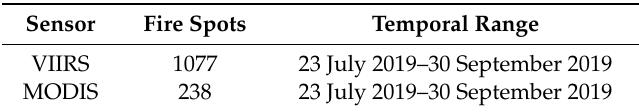
Table 1. The fire spot distribution in the Pantanal wetland from August to September, 2019. MODIS: Moderate Resolution Imaging Spectroradiometer.